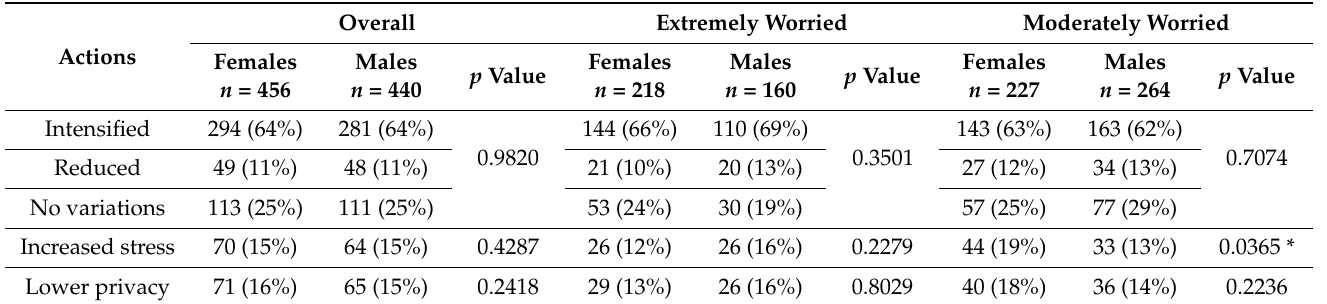
Table 4. Gender differences in relationships during